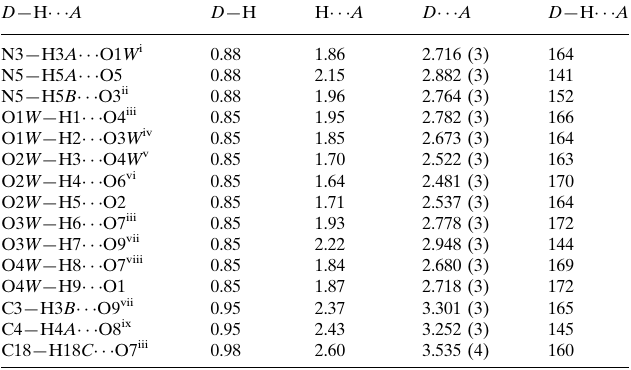
Hydrogen-bond geometry (A˚ , (cid:4)